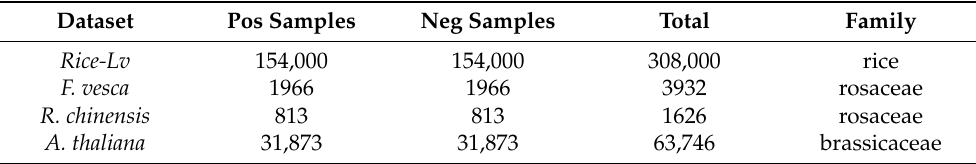
Table 3. Benchmark dataset; Rice-Lv ; and cross-species testing datasets, Fragaria vesca , Rosa chinensis , and Arabidopsis thaliana , used in this